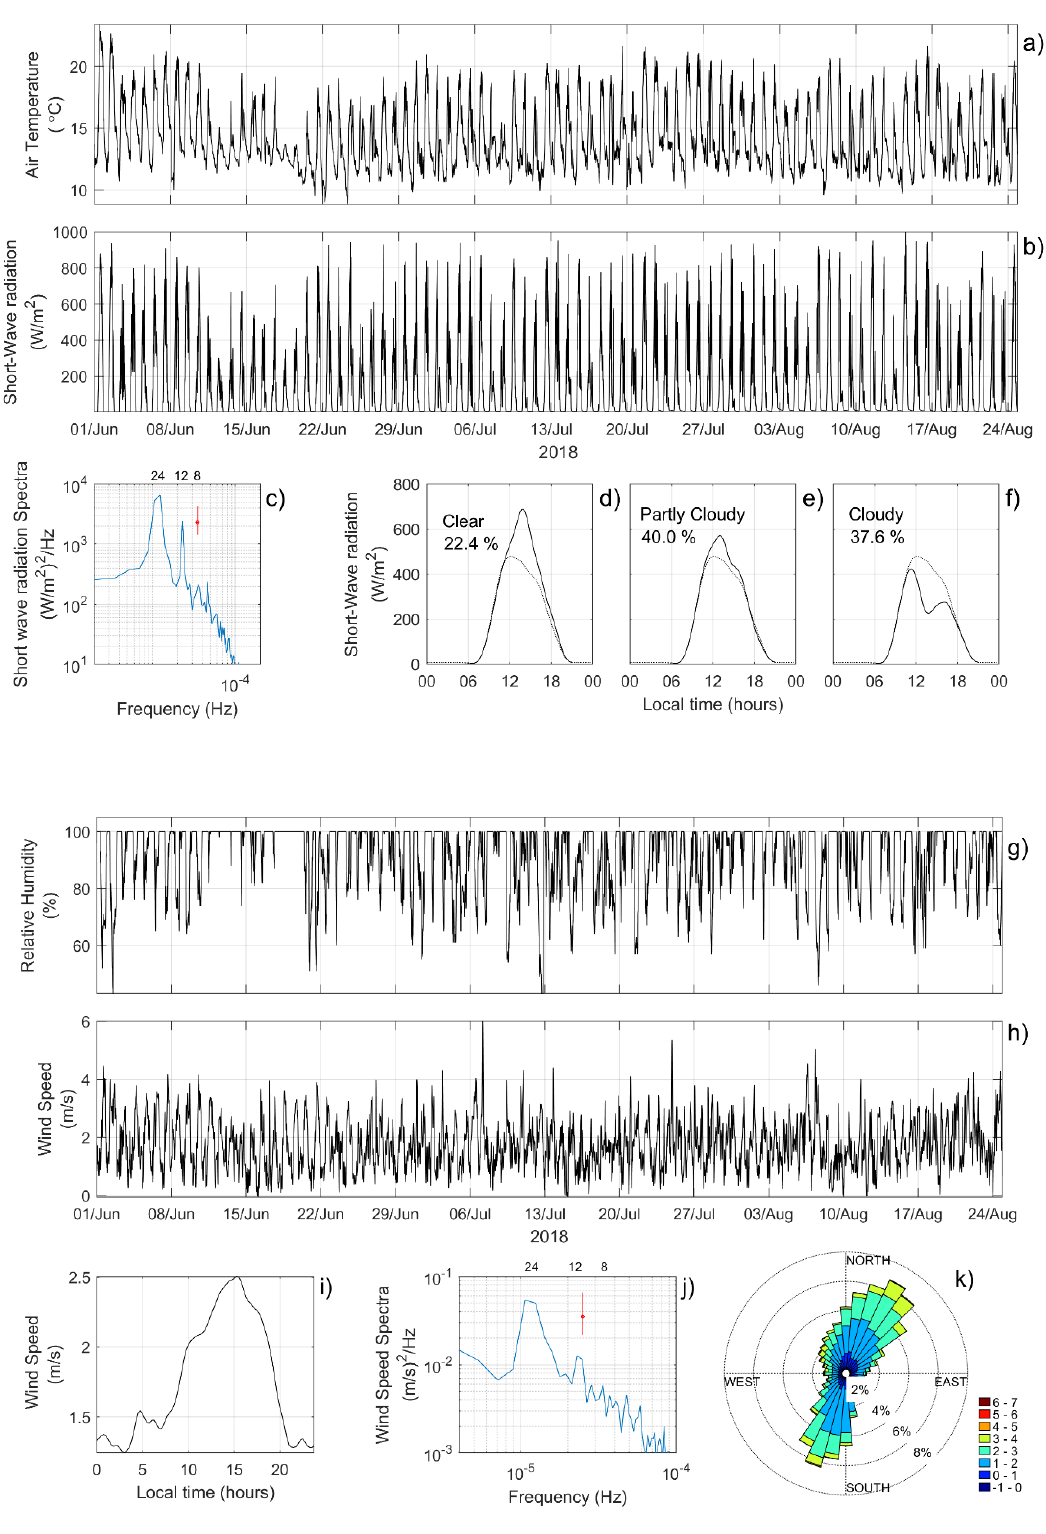
Figure 4. Meteorological data of ( a ) air temperature, ( b ) short-wave radiation with ( c ) short-wave radiation spectra and a daily cycle classification at ( d – f ). In ( g ), relative humidity and in ( h ), wind speed, ( i ) daily wind speed, ( j ) wind spectra and ( k ) the wind rose, obtained from a weather station located approximately 10 km south of the lake. These meteorological data were used in the numerical model.